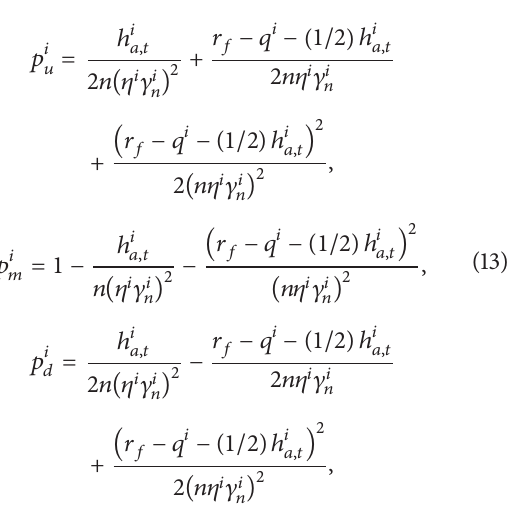
Table 1: Full volatility information at node ( 𝑡 , 𝑚 ).